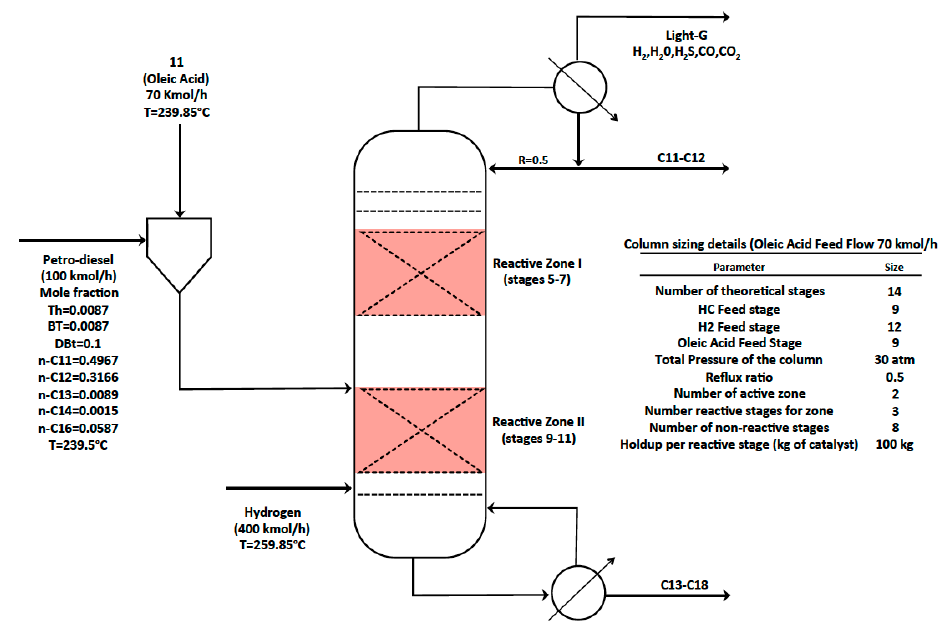
Figure 4. Hydrotreating two-zone reactive distillation column. Oleic acid premixed with sulphured petro-diesel fed at stage 9.